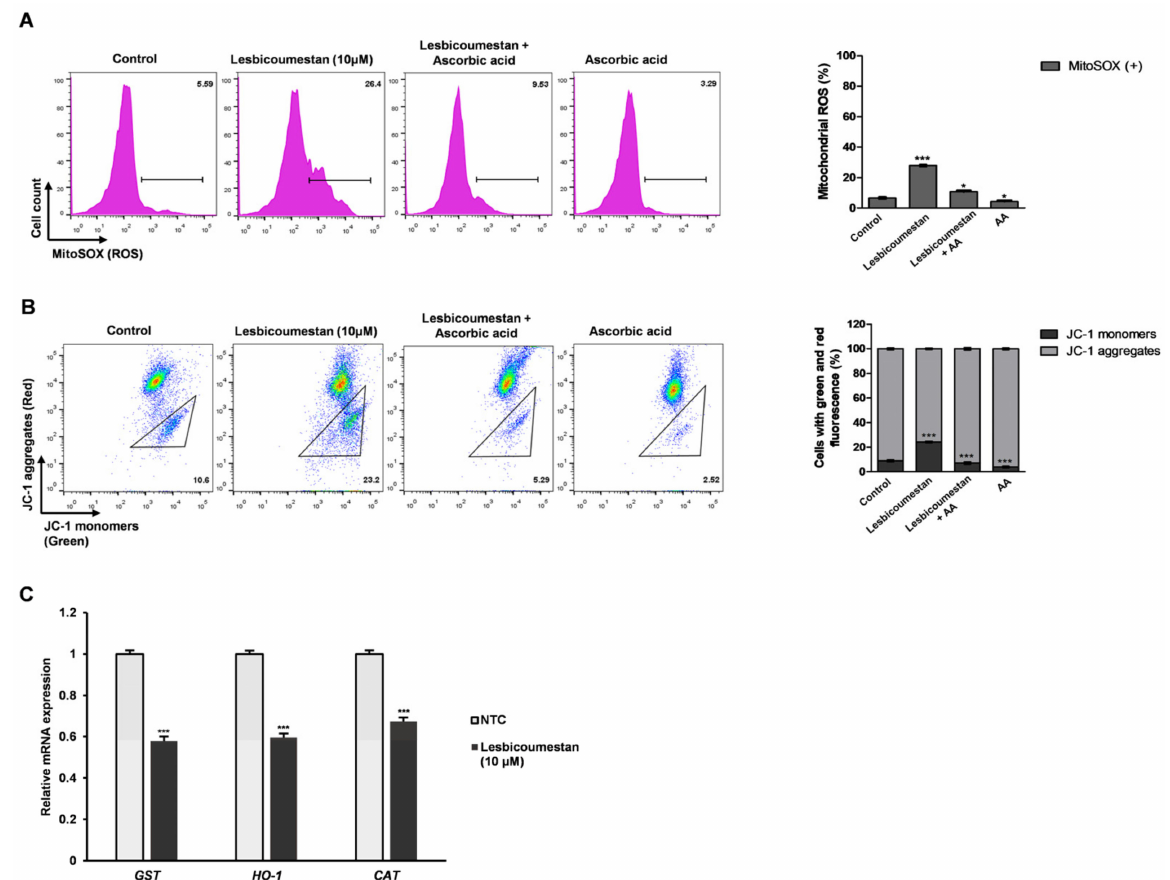
Figure 3. Lesbicoumestan-induced apoptosis via reactive oxygen species (ROS) generation, mitochondrial dysfunction, and reduced the mRNA expression level of antioxidant genes. ( A ) Jurkat cells were treated with lesbicoumestan and ascorbic acid (AA), and mitochondrial ROS was indicated by MitoSOX Red. Flow cytometry was employed to analyze the Jurkat cells. ( B ) Mitochondrial membrane potentials (MMPs) of Jurkat cells treated with lesbicoumestan, as measured via flow cytometry with JC-1 (5 (cid:48) ,6,6 (cid:48) -tetrachloro-1,1 (cid:48) ,3,3 (cid:48) -tetraethylbenzimidazolylcarbocyanine iodide) staining. Quantification of the JC-1 green and red fluorescence of the experiments of silencing or overexpressing lesbicoumestan and ascorbic acid in Jurkat cells ( n = 3, * p ≤ 0.05, *** p ≤ 0.001 vs. control group). ( C ) Effect of lesbicoumestan on the mRNA expression levels of involved antioxidants in Jurkat cells. The qRT-PCR analysis results of GST , HO-1 , and CAT mRNA levels in the control and in the Jurkat cells treated with 10 µ M lesbicoumestan ( n = 3, *** p ≤ 0.001) were